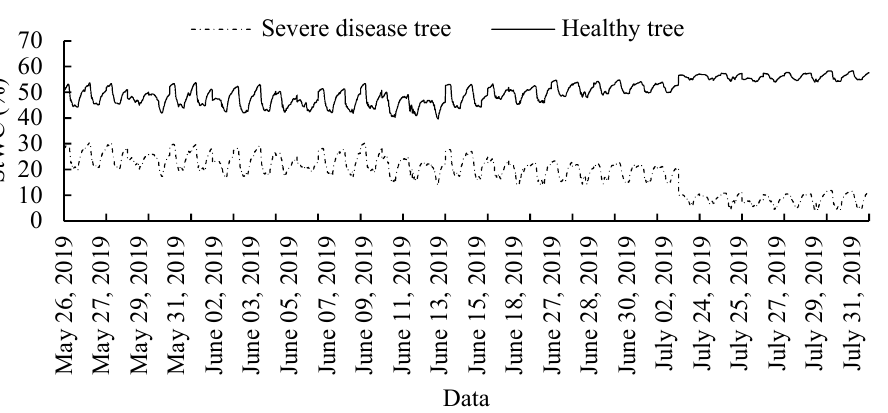
Figure 4. Changing curves of StWC in Lagerstroemia indica L. with different health levels during the period of germination.